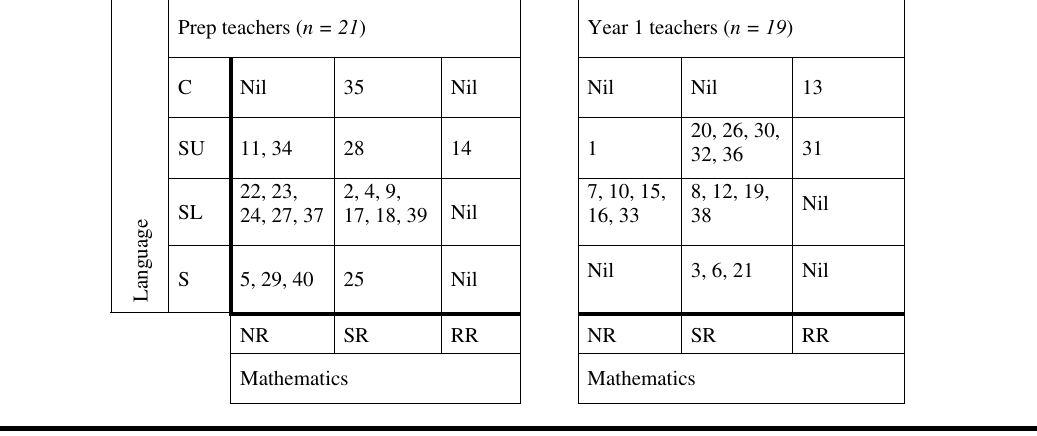
Comparing the Preparatory teachers with the Year 1